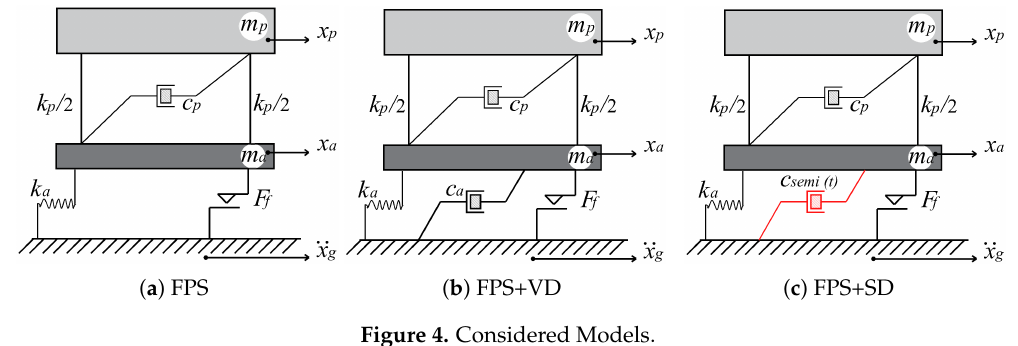
Figure 4. Considered